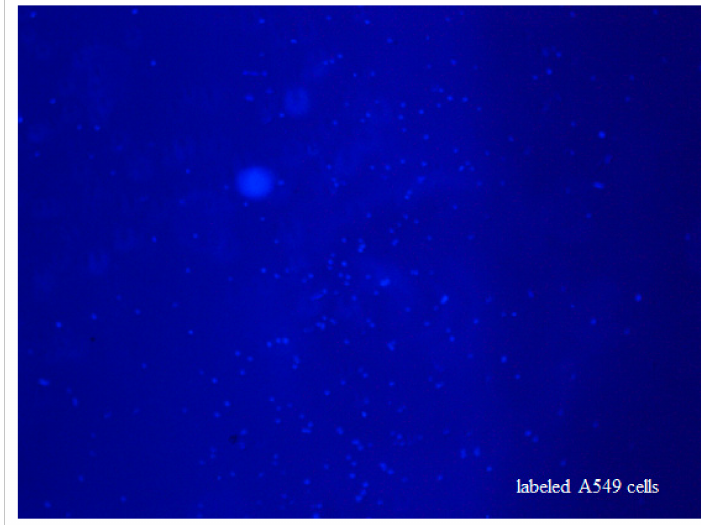
Figure 3. Fluorescence image of labeled A549 cells on a glass